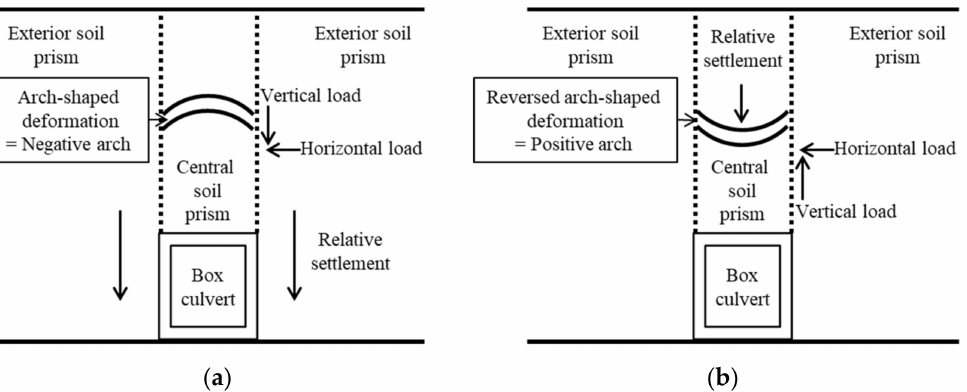
Figure 1. Soil behaviors with relative settlement: ( a ) embankment and ( b ) trench installation (modi- fied after [32]).